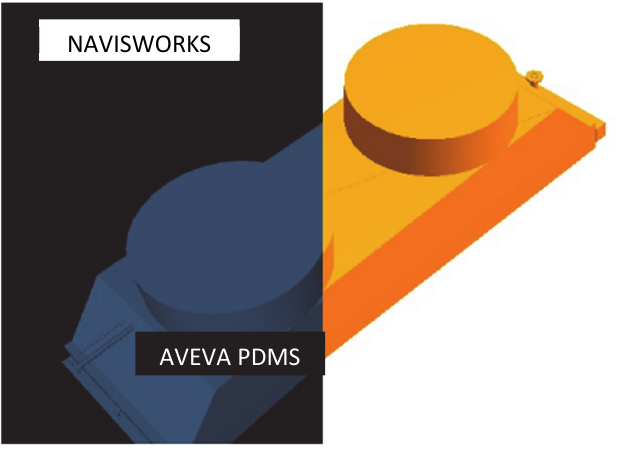
Fig. 5. Navisworks vs. PDMS Equipment’s 3D Model